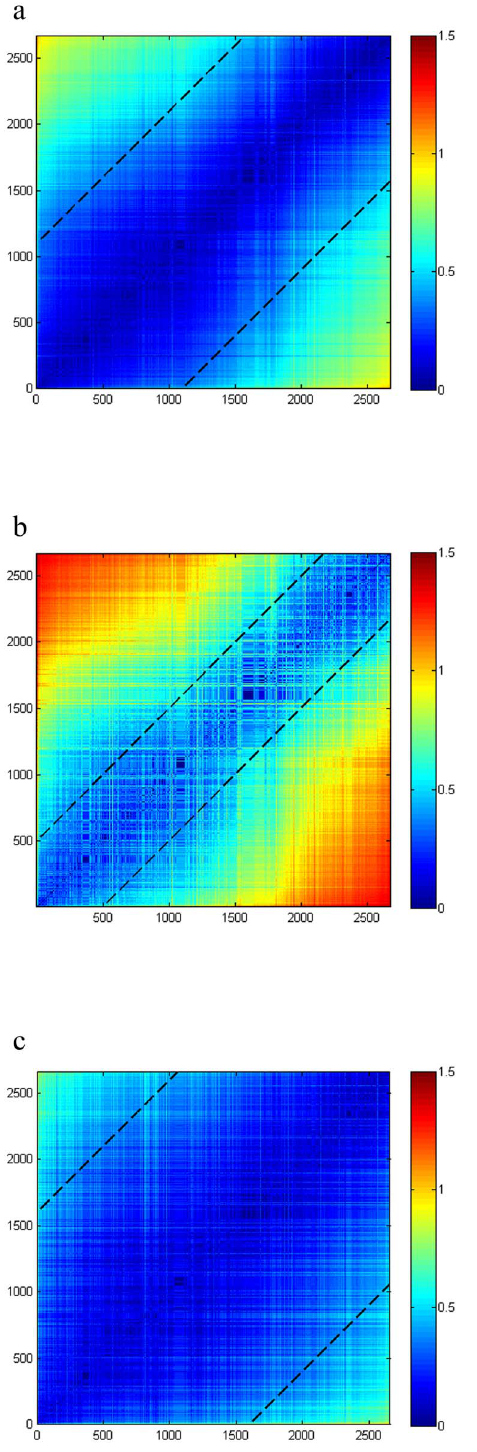
Figure 2. Vector distance of two genomes plotted against their GC content difference. a) Y: Base distance; X: D-value of GC content. b) Y: Codon distance; X: D-value of GC content. c) Y: Amino acid distance; X: D-value of GC content.